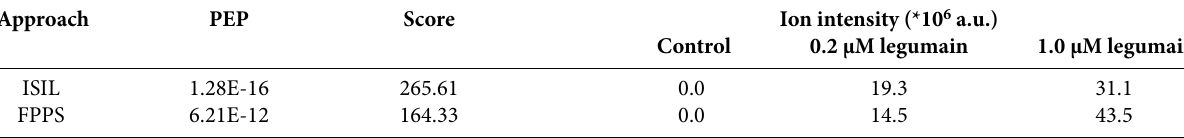
Table 1. The ion intensity of prelamin-A/C peptide AcD3-LVGAAHEELQQSR determined by ISIL and FPPS approach. Approach